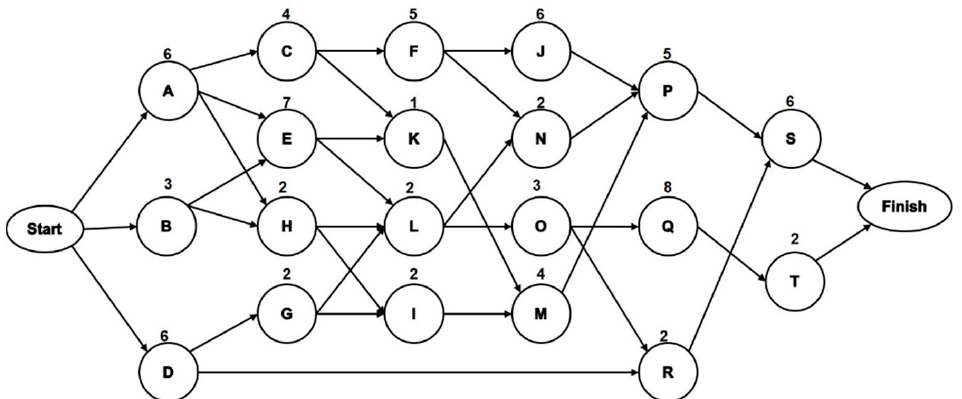
Figure 3. Network Diagram for Project B.